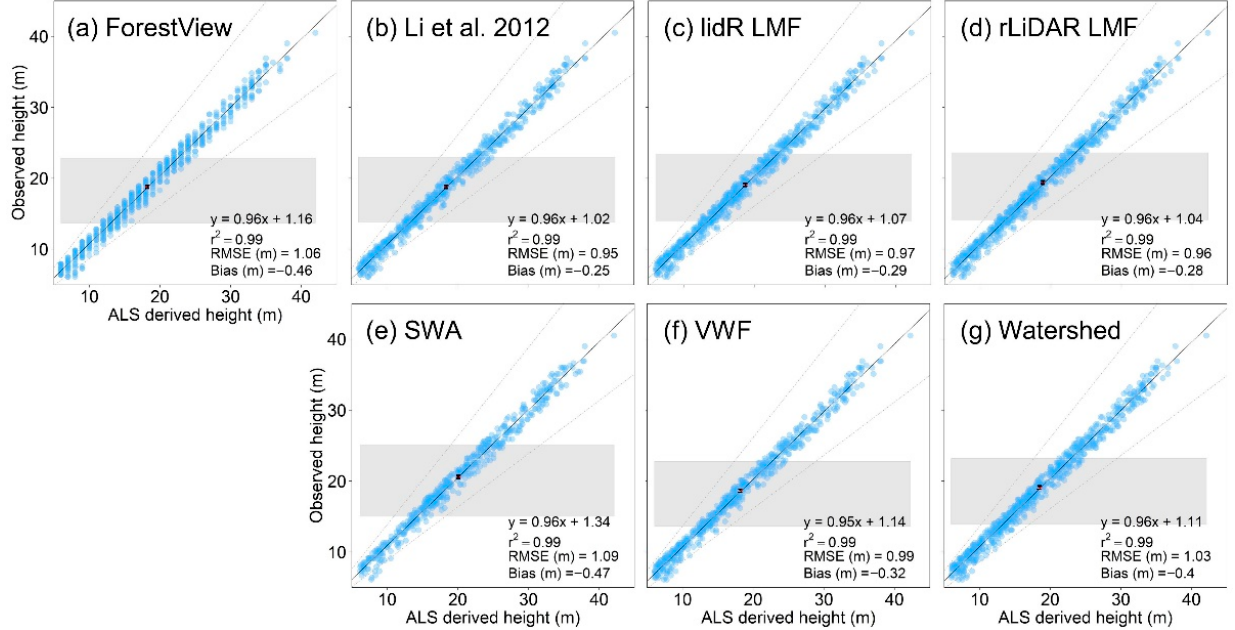
Figure 5. Equivalence test graphs for reference tree height versus tree height from top method approaches derived from the 8 ppm 2 ALS dataset highlighted in Table 4. The grey polygon represents the ± 25% region of equivalence for the intercept. The ALS-derived and cruised heights are equivalent to the felled height when the vertical red bar is completely within the grey polygon. The grey dashed lines represent the ± 25% region of equivalence for the slope. If the vertical black bar is within the grey dashed lines, then the regression slope is significantly similar to 1. The solid black line represents the best-fit linear regression model. The method shown in ( b ) refers to [19].